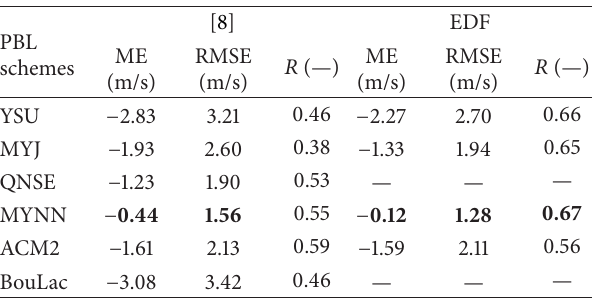
Table7:Mu˜noz-Esparzaetal.[8]versusEDFstatisticalmetrics(ME in m/s, RMSE in m/s, and 𝑅 ) for the 100m wind speed, so as to evaluate the WRF performance with different PBL